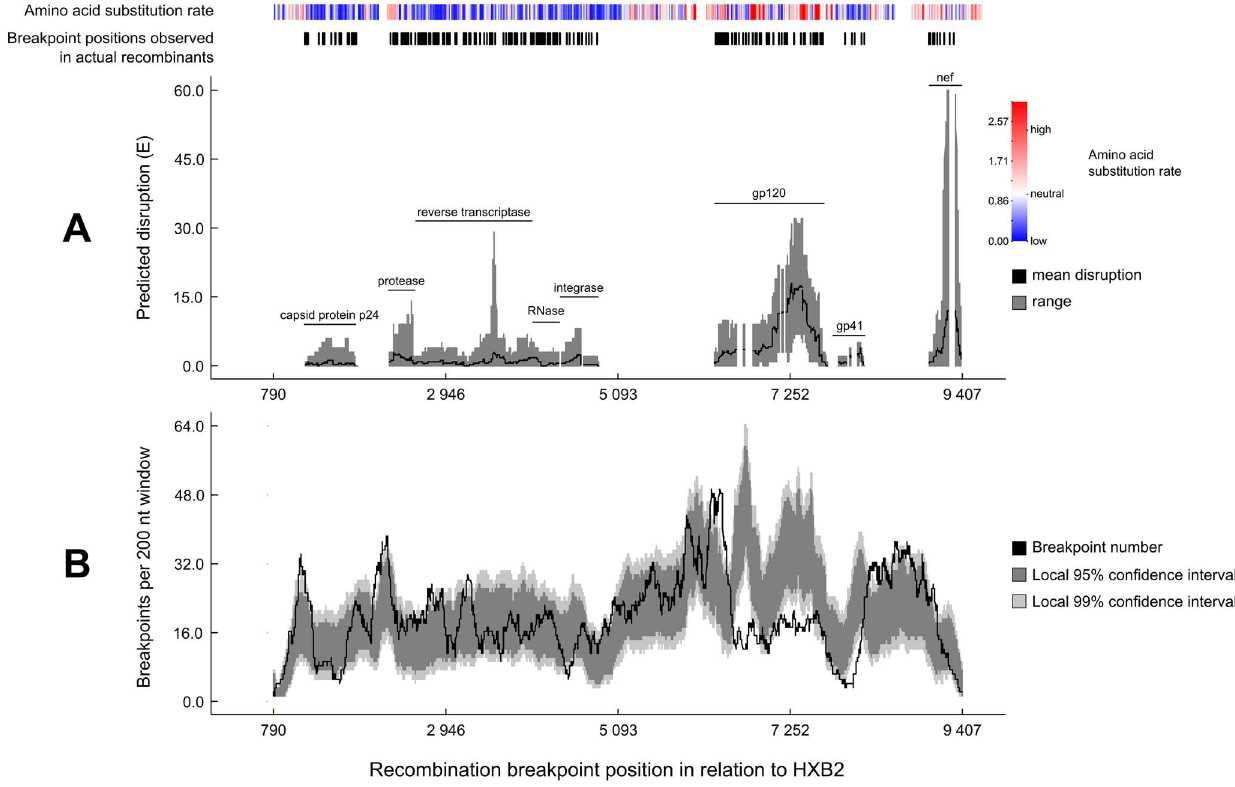
Figure 2. The predicted sensitivity of HIV-1M proteins to recombinational disruption. ( A ) Depicted are the means (black lines) and ranges (gray backgrounds) of predicted degrees of recombination-induced folding disruption in various HIV-1 proteins (those for which suitable atomic resolution three dimensional structures are available). The white areas interspersed between the gray areas are positions where there was no protein structure data available or where there were extra amino acids inserted into the alignment that were not present in the protein structure used. For all genome regions that had associated protein structure data, all conceivable single breakpoint recombinants were simulated using parental sequences that resembled as closely as possible the parental sequences of actual recombinant viruses with single detectable recombination breakpoints in these genome regions. Amino acid substitution rates and breakpoint positions occurring in these actual HIV-1 recombinants are displayed at the top of the figure. ( B ) Recombination breakpoint density plot illustrating breakpoint positions detected across 434 detectable HIV-1M recombination events (After [14]). Light and dark grey areas respectively indicate the 95% and 99% confidence intervals of breakpoint numbers that would have been detectable in different genome locations under random recombination. The grey areas undulate with degrees of sequence conservation because recombination events are more easily detectable in genome regions that are genetically diverse. Note firstly that the peaks of the plots in A indicate recombination breakpoint positions that are predicted to have the greatest disruptive effects on protein folding, and secondly that in actual recombinant HIV-1M genomes sampled from nature these ‘‘disruptive breakpoint positions’’ tend to correspond in plot B with regions of low recombination breakpoint densities.